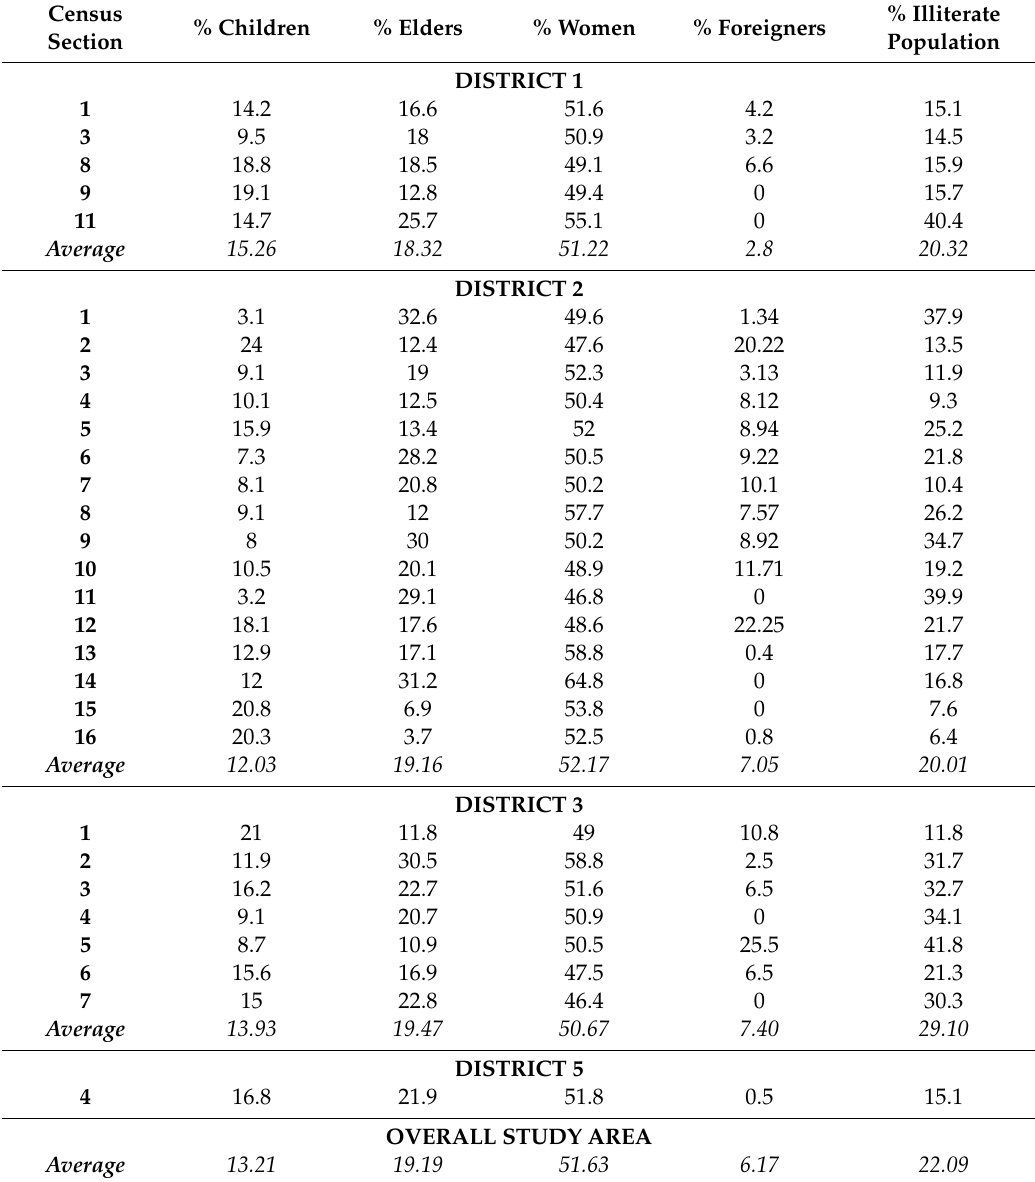
Table 5. Indicators related to age, gender, foreigners and education in Ponferrada. The highest values appear in bold